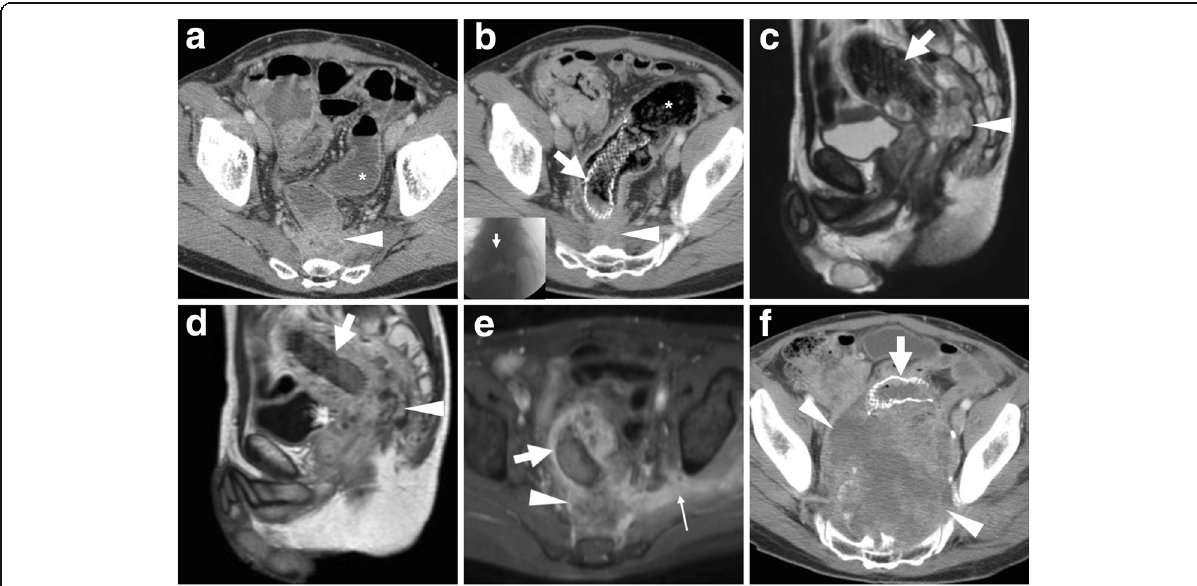
Fig. 9 Stent management of an extracolonic pelvic tumour and neoplastic outgrowth. After diagnosis of local recurrence (arrowheads in CT, a ) of previously resected rectal cancer causing upstream bowel obstruction (*), palliative positioning of a SEMS (thick arrows) was performed (post- procedural CT ( b ), intraprocedural fluoroscopy in inset). Despite intensive chemotherapy, follow-up MRI including sagittal T2- ( c ), post-gadolinium sagittal ( d ) and fat-suppressed axial ( e ) T1-weighted images confirmed patent SEMS (thick arrows) and progressive inhomogeneity of tumour mass (arrowheads) consistent with abscess formation and development of fistulisation through the right ischiatic foramen (thin arrow in e ). The neoplastic recurrence (arrowheads in CT, f ) ultimately grew to massive size causing ventral dislocation and compression of the SEMS (thick arrow)